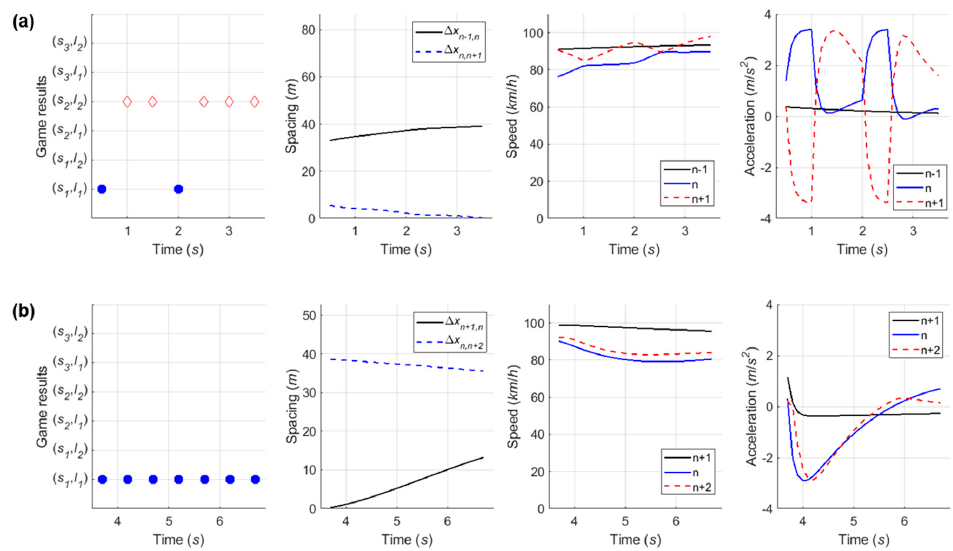
Figure 27. Decision-making game results in case 5 using the one-shot game model: ( a ) Initial game with (cid:1866) + 1 ; ( b ) additional game with (cid:1866) + 2 .